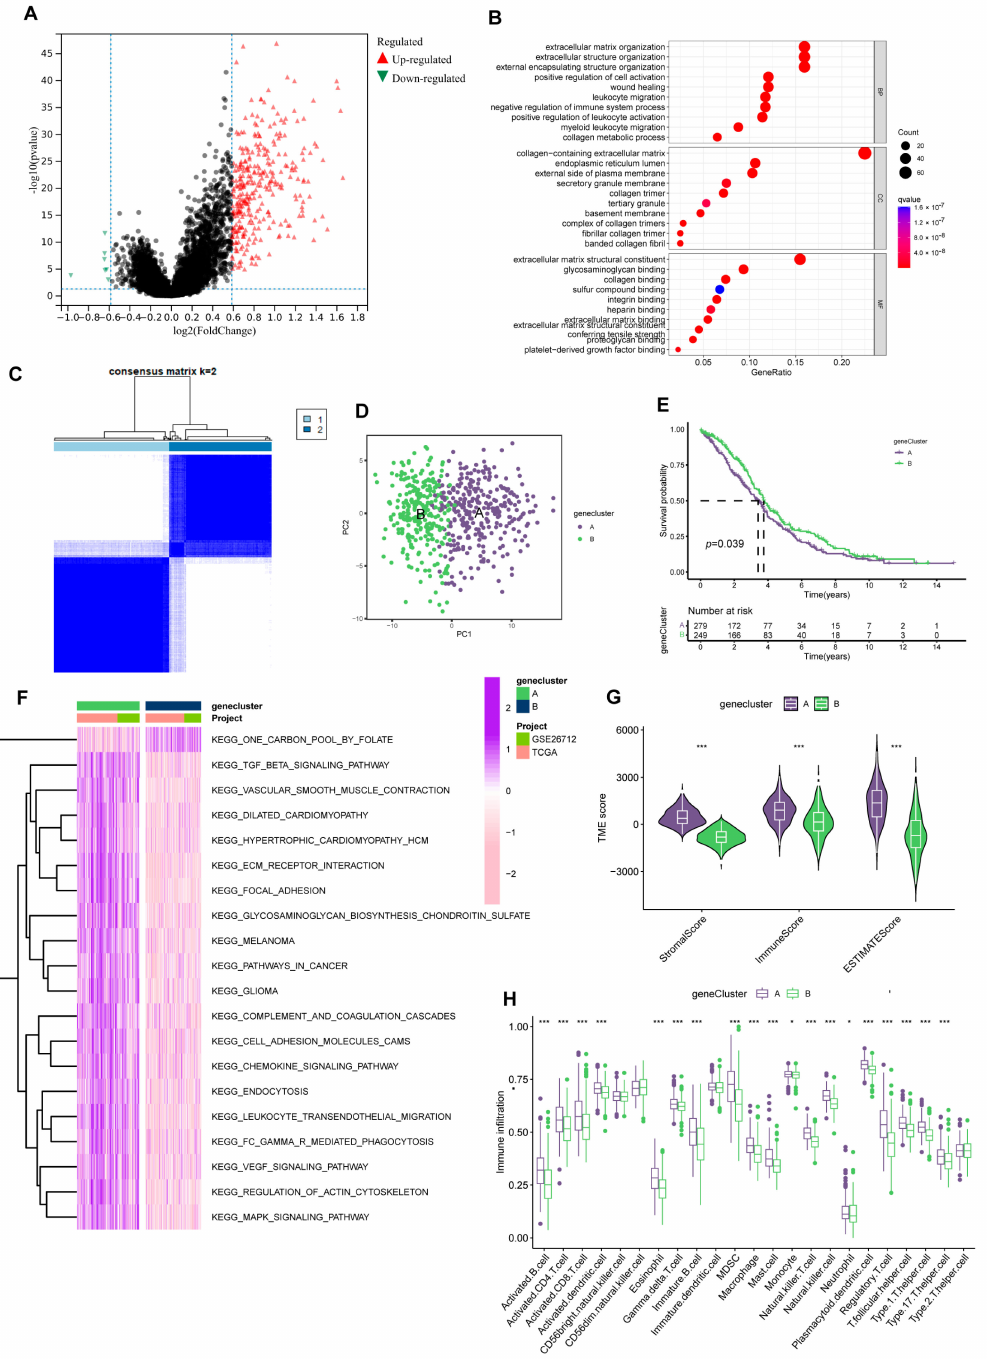
Figure 4. Prognosis-related gene clusters identification. ( A ) The DEGs of subtype A and subtype B. ( B ) GO analysis of 322 DEGs . ( C ) The consensus matrix identifies two gene clusters (k = 2). ( D ) PCA analysis demonstrated significant transcriptome differences between the two clusters. ( E ) Gene clusters were closely related to OS in OV. ( F ) GSVA analysis of the KEGG pathways in gene clus- ters. ( G ) Different clusters differ in TME scores (stromal score and immune score). (*** p < 0.001). ( H ) Immune function analysis of two sets. (* p < 0.05; *** p <